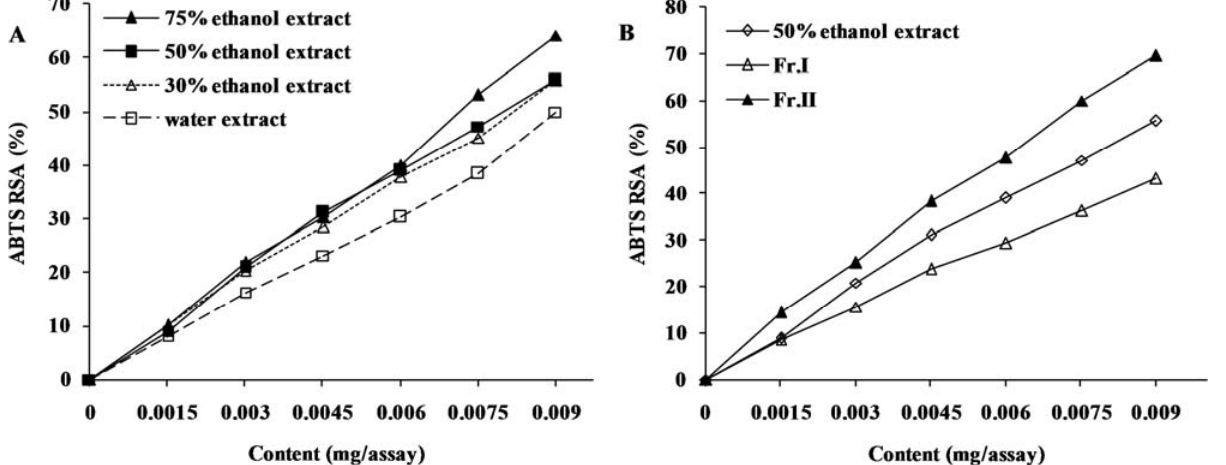
Figure 2. ABTS radical scavenging activity (RSA) of C. mollissima burs extracts ( A ) and fractions ( B ).